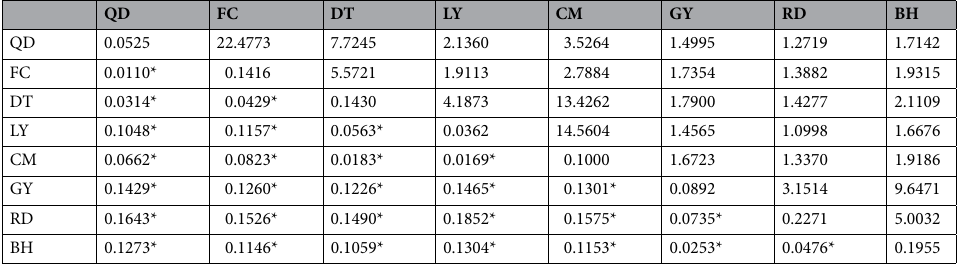
Table 3. Genetic differentiation coefficient (Fst, below diagonal), gene flow (Nm, above diagonal) and inbreeding coefficient (Fis, on diagonal) for eight L. maculatus populations. LY Lieyu, CM Chongming, DT